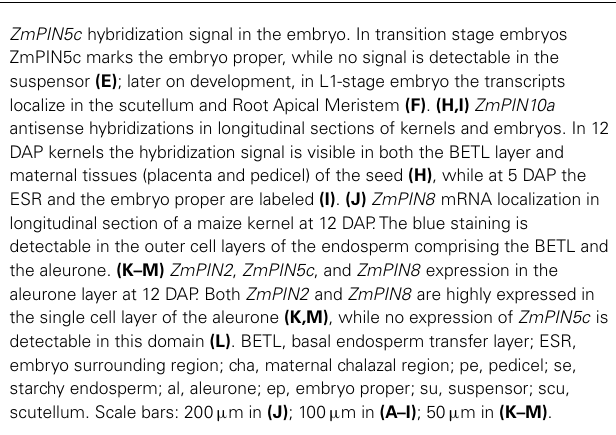
ZmPIN5c hybridization signal in the embryo. In transition stage embryos ZmPIN5c marks the embryo proper, while no signal is detectable in the suspensor (E) ; later on development, in L1-stage embryo the transcripts localize in the scutellum and Root Apical Meristem (F) . (H,I) ZmPIN10a antisense hybridizations in longitudinal sections of kernels and embryos. In 12 DAP kernels the hybridization signal is visible in both the BETL layer and maternal tissues (placenta and pedicel) of the seed (H) , while at 5 DAP the ESR and the embryo proper are labeled (I) . (J) ZmPIN8 mRNA localization in longitudinal section of a maize kernel at 12 DAP.The blue staining is detectable in the outer cell layers of the endosperm comprising the BETL and the aleurone. (K–M) ZmPIN2 , ZmPIN5c , and ZmPIN8 expression in the aleurone layer at 12 DAP. Both ZmPIN2 and ZmPIN8 are highly expressed in the single cell layer of the aleurone (K,M) , while no expression of ZmPIN5c is detectable in this domain (L) . BETL, basal endosperm transfer layer; ESR, embryo surrounding region; cha, maternal chalazal region; pe, pedicel; se, starchy endosperm; al, aleurone; ep, embryo proper; su, suspensor; scu, scutellum. Scale bars: 200 μ m in (J) ; 100 μ m in (A–I) ; 50 μ m in (K–M) .